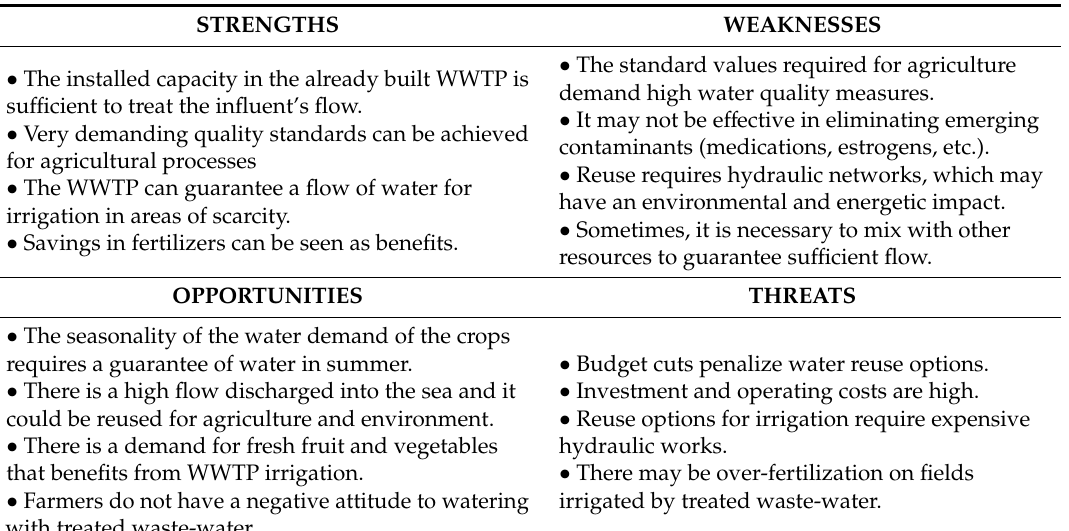
Table 1. SWOT matrix obtained from experts’ interviews on the treated waste-water